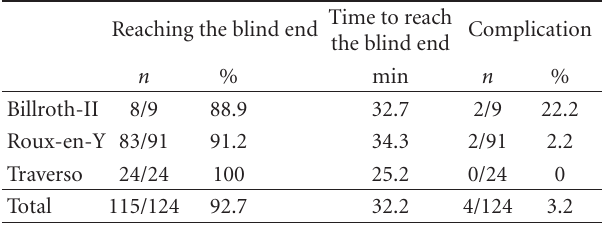
Table 1: Reconstruction methods and the results of DBE